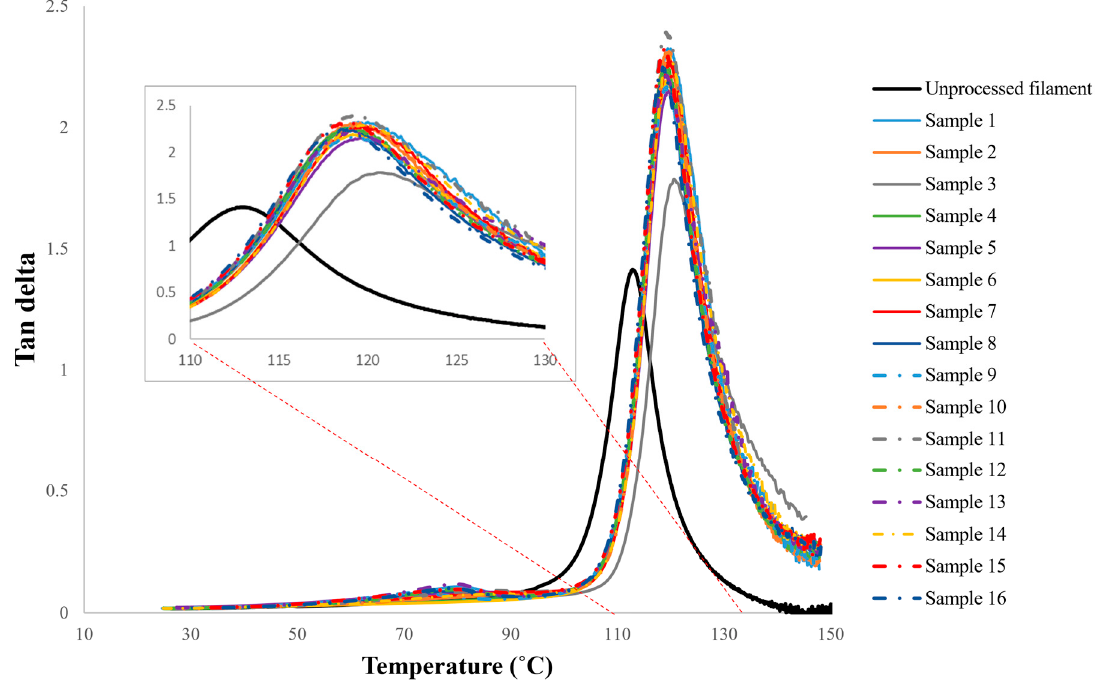
Figure 6. The variation of tan delta versus temperature for the test specimens, with the more detailed view of the variation in the range of 110 ℃ to 130 ℃ .